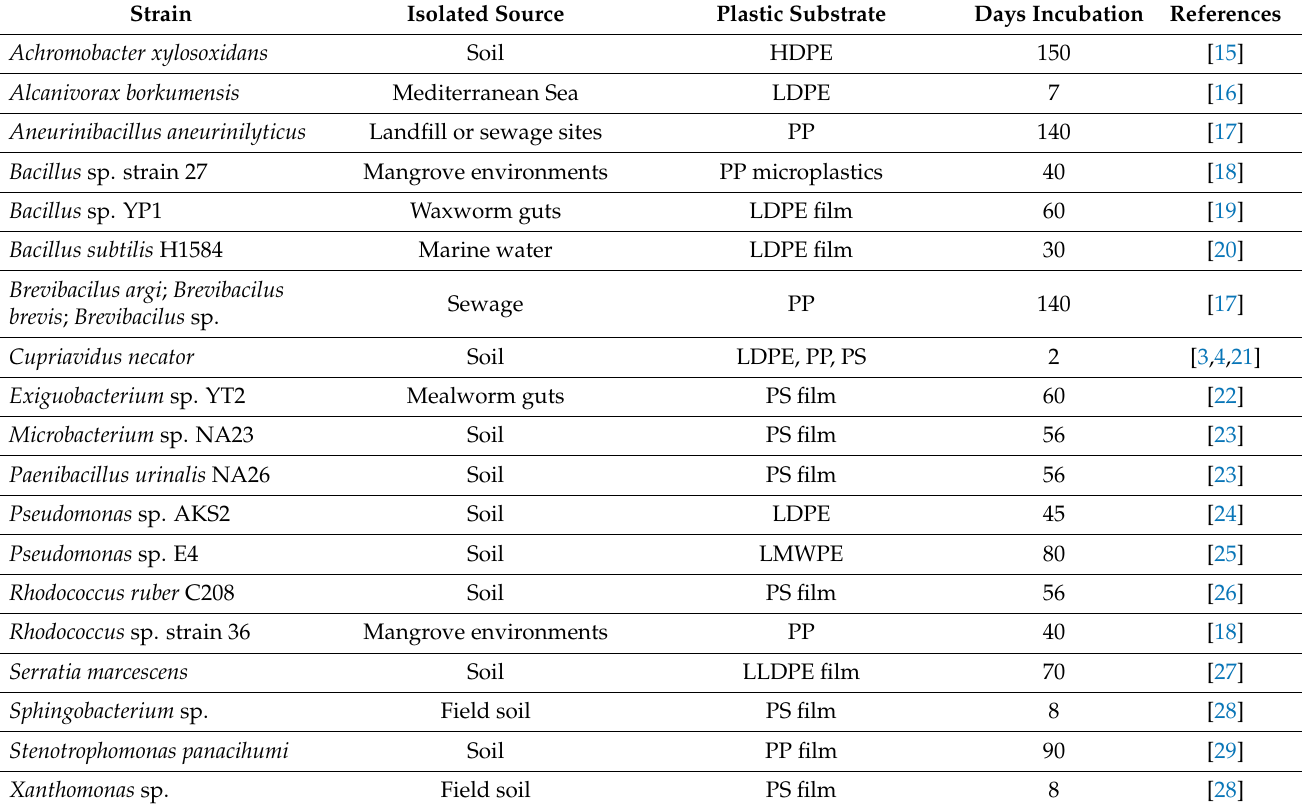
Table 1. Bacterial strains and polyolefins